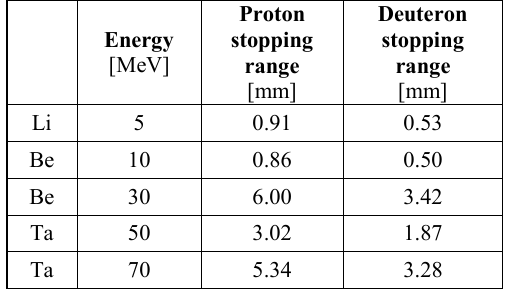
Table 1. Stopping range for protons and deuterons for various target materials and energies calculated with SRIM 2013 [14]. Energy